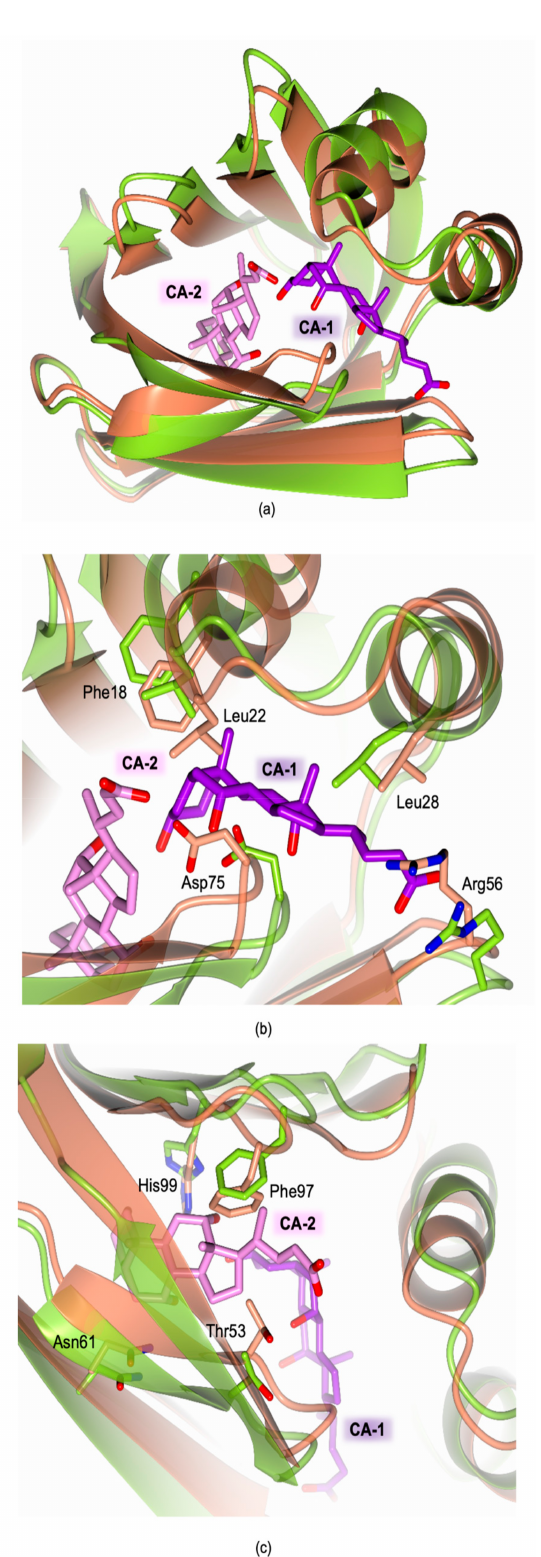
Figure 7. Structural comparison between the recombinant cL-BABP (coral cartoon and carbons) and its complex with CA (green–yellow cartoon and carbons; CA-1 and CA-2 in sticks, violet, and pink carbons, respectively). ( a ) Ligand cavity view showing the aperture occurring upon CA binding, required to accommodate the bile acids molecules. ( b , c ) View of the structural rearrangements occurring in the cL-BABP site 1 ( b ) and site 2 ( c